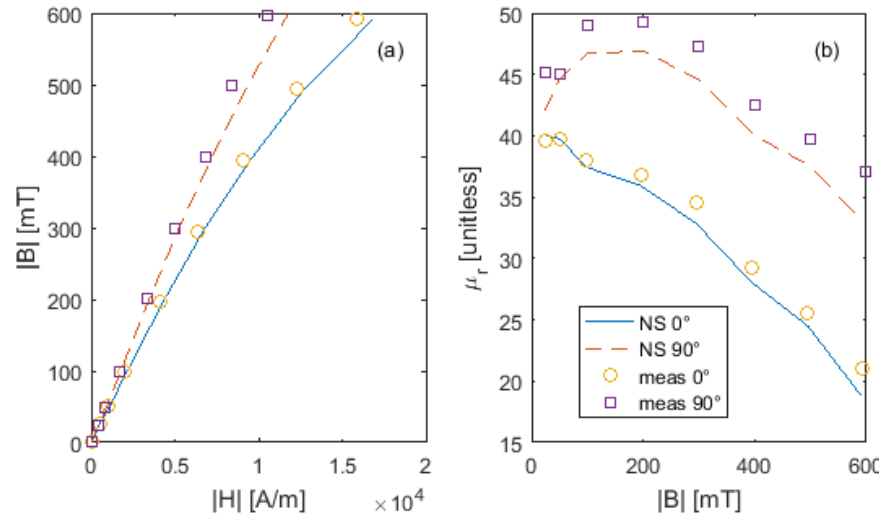
Figure 13. ( a ) First magnetization curve along both the x- and the y-axis computed from either the simulated or the measured scalar hysteresis cycles. ( b ) Relative permeability versus the amplitude of the magnetic induction evaluated along both the x- and the y-axis from either the simulated and the measured scalar hysteresis cycles.